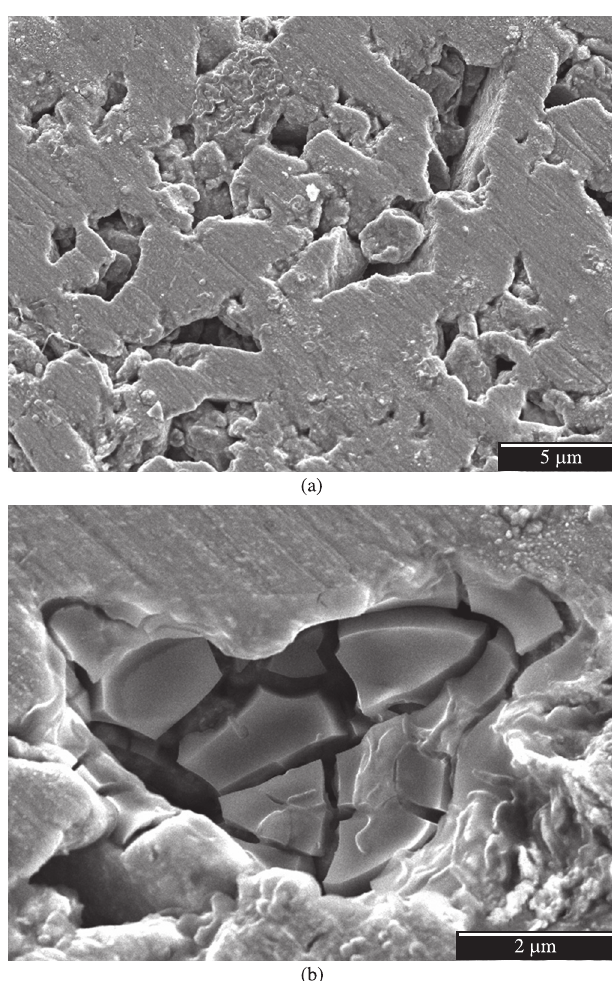
Figure 7. Pitting potential of compacted green Al-15at.%Mo powder, meas- ured galvanostatically in 1M NaCl solution.